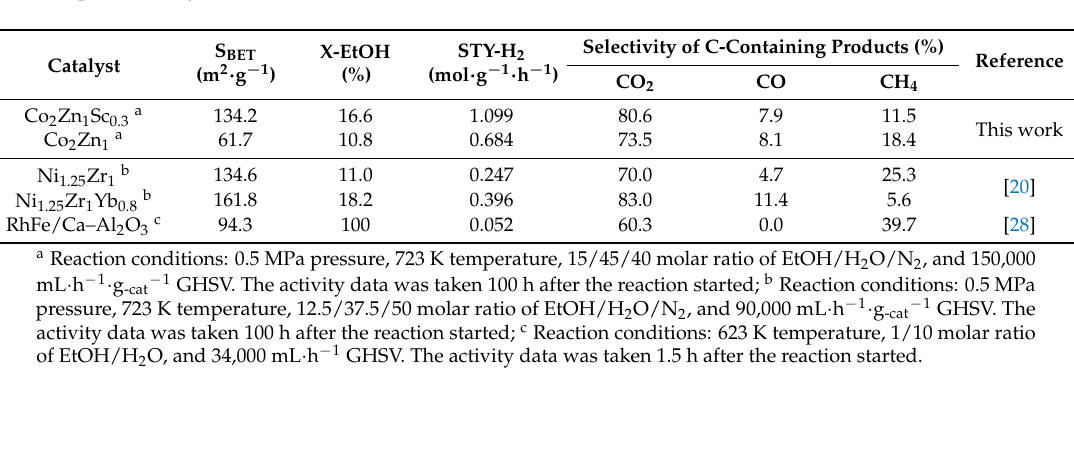
Table 1. Reactivity of ESR for H 2 production over Co 2 Zn 1 Sc 0.3 and Co 2 Zn 1 and the other compared catalysts.